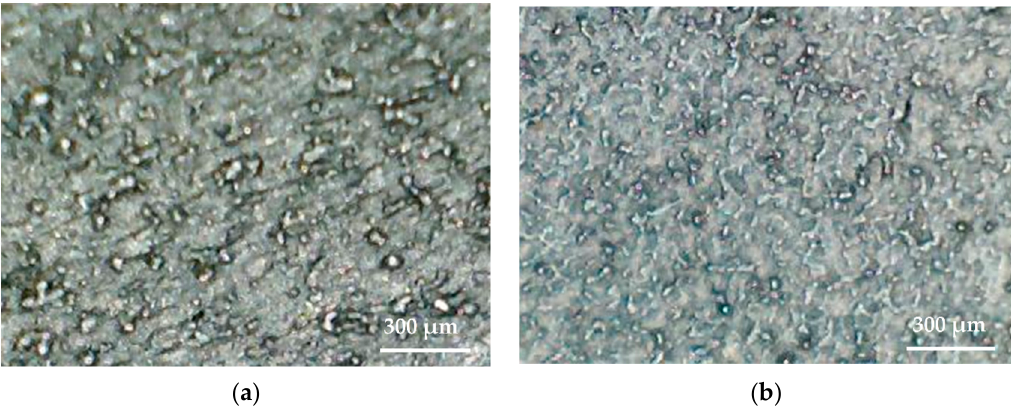
Figure 6. Surface topology of the samples (optical microscopy, 300×): ( a ) after production; ( b ) after cavitation-abrasive finishing.